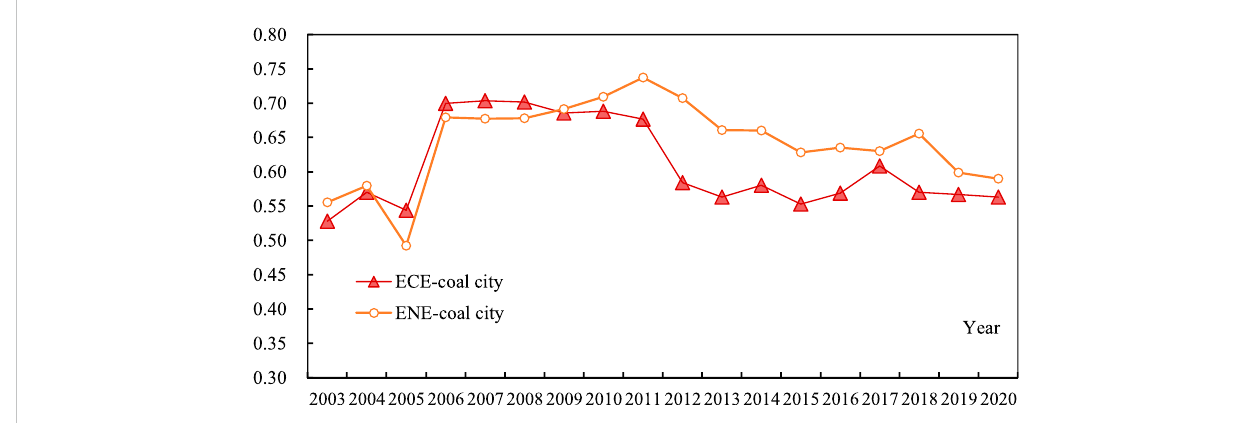
The time changes in environmental and economic ef fi ciencies of coal cities.